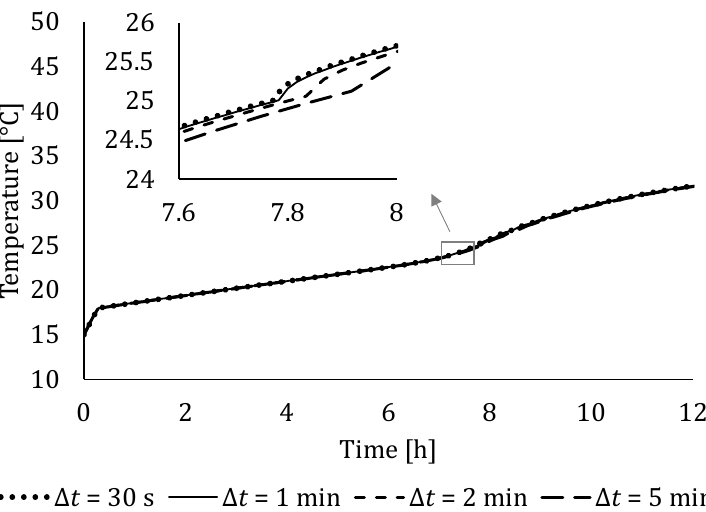
Figure 6. Transient PCM temperature variations at the middle axial position of LTES during melting for HTF flow rate 620 l/h and HTF inlet temperature 37 °C, obtained by a computational model with different time step sizes.